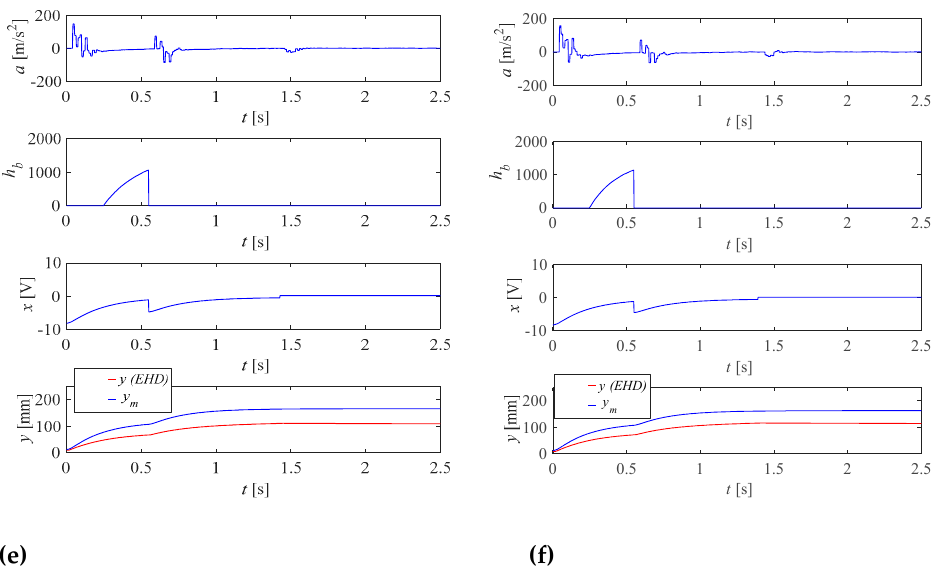
Figure 9. Acceleration a , calculated integral from acceleration h b , set-point hitting the drive valve x and actual position of the piston rod y for: ( a ) p 0 = 5 MPa, u = 80 mm; ( b ) p 0 = 9 MPa, u = 80 mm; ( c ) p 0 = 11 MPa, u = 80 mm; ( d ) p 0 = 5 MPa, u = 110 mm; ( e ) p 0 = 9 MPa, u = 110 mm; ( f ) p 0 = 11 MPa, u = 110 mm.